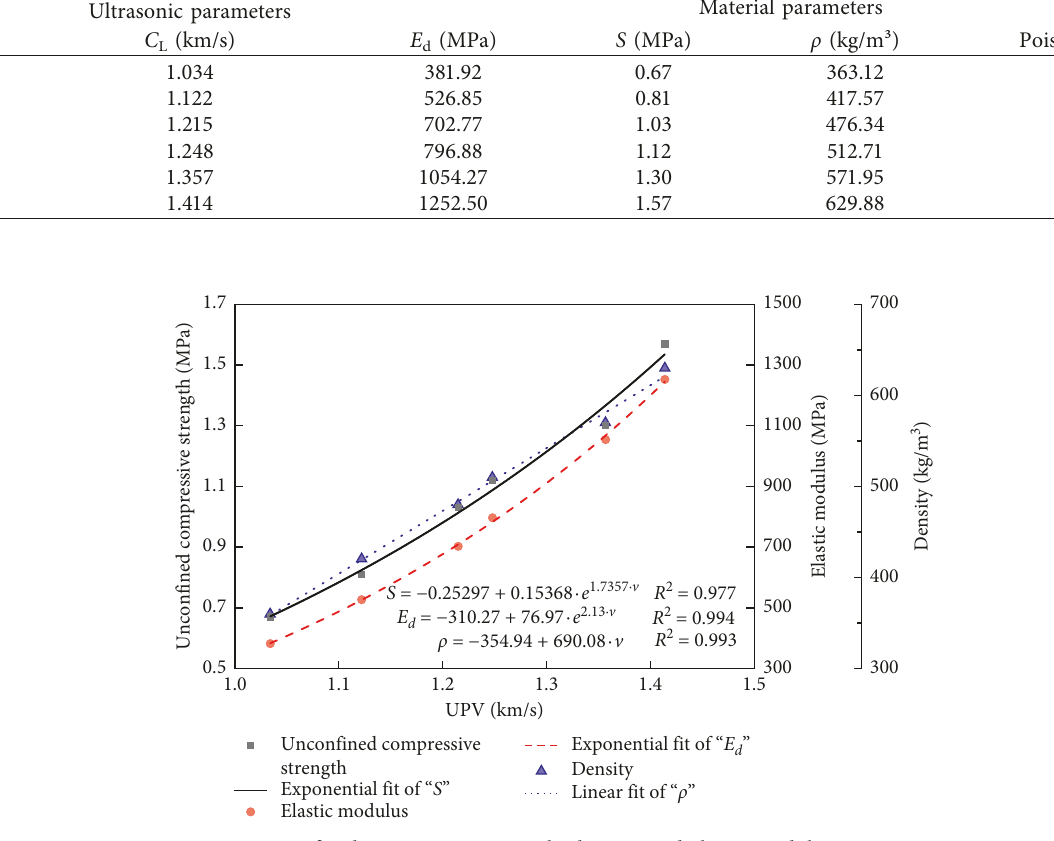
Figure 8: Unconfined compressive strength, density, and elastic modulus versus UPV.